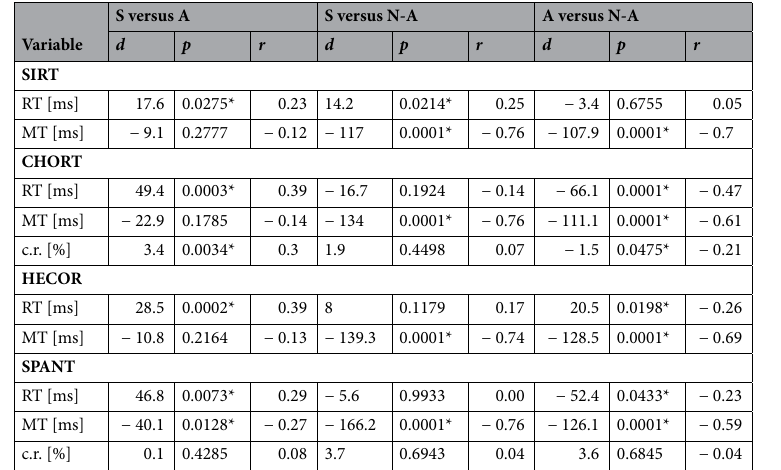
Table 2. Differences between groups. SIRT simple reaction time, CHORT choice reaction time, HECOR hand-eye coordination test, SPANT spatial anticipation test, RT reaction time, MT movement time, c.r. correct responses, d difference, p statistical probability, r effect size for the the Mann–Whitney–Wilcoxon test. *Statistical